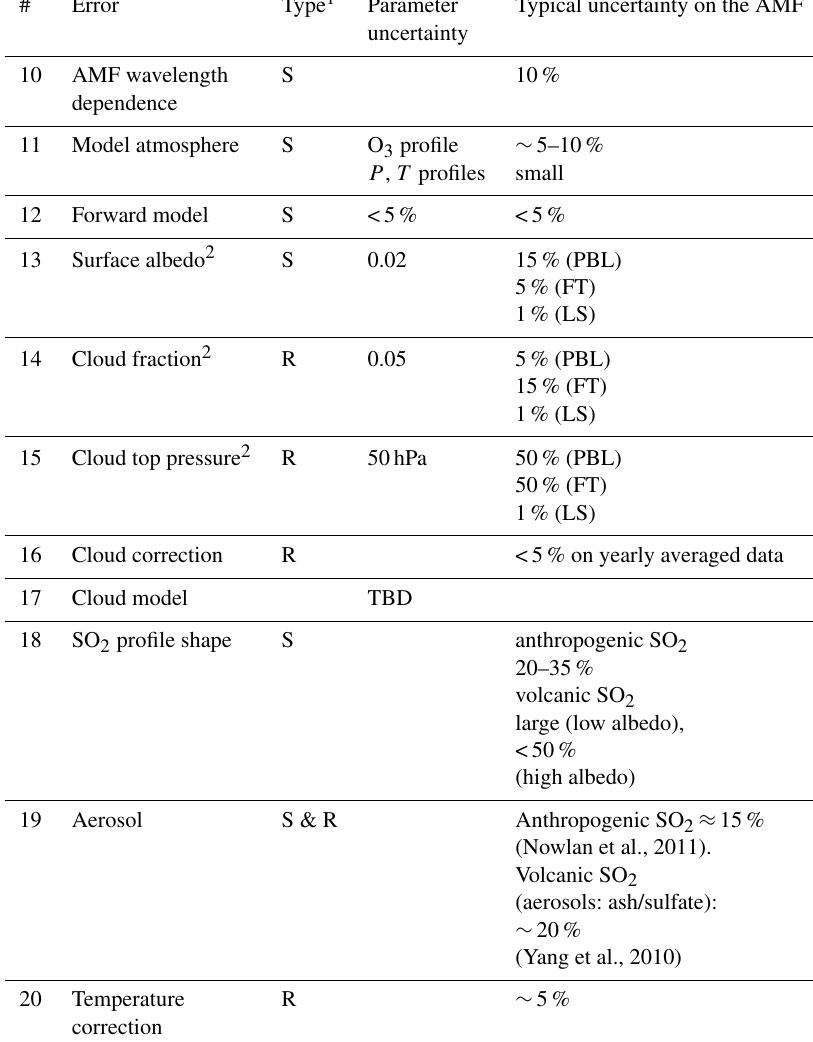
Table 6. Systematic and random error components contributing to the total uncertainty on the SO 2 air mass factor. # Error Type 1 Parameter Typical uncertainty on the AMF uncertainty 10 AMF wavelength S 10% dependence 11 Model atmosphere S O 3 profile ∼ 5–10% P , T profiles small 12 Forward model S <5% <5% Surface albedo